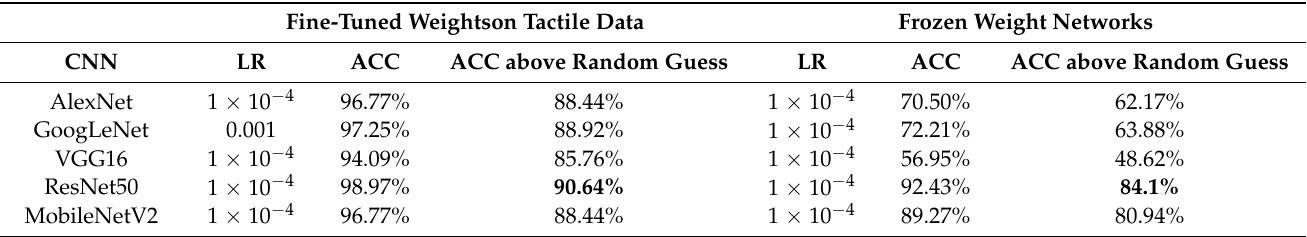
Table 2. Classification results for ViTac dataset. All networks are trained on a minimum batch of size 16 and for 10 epochs.